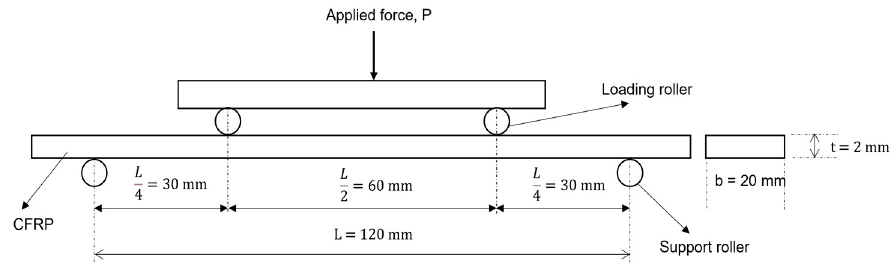
Figure 7. Four-point bending specimen schematic.